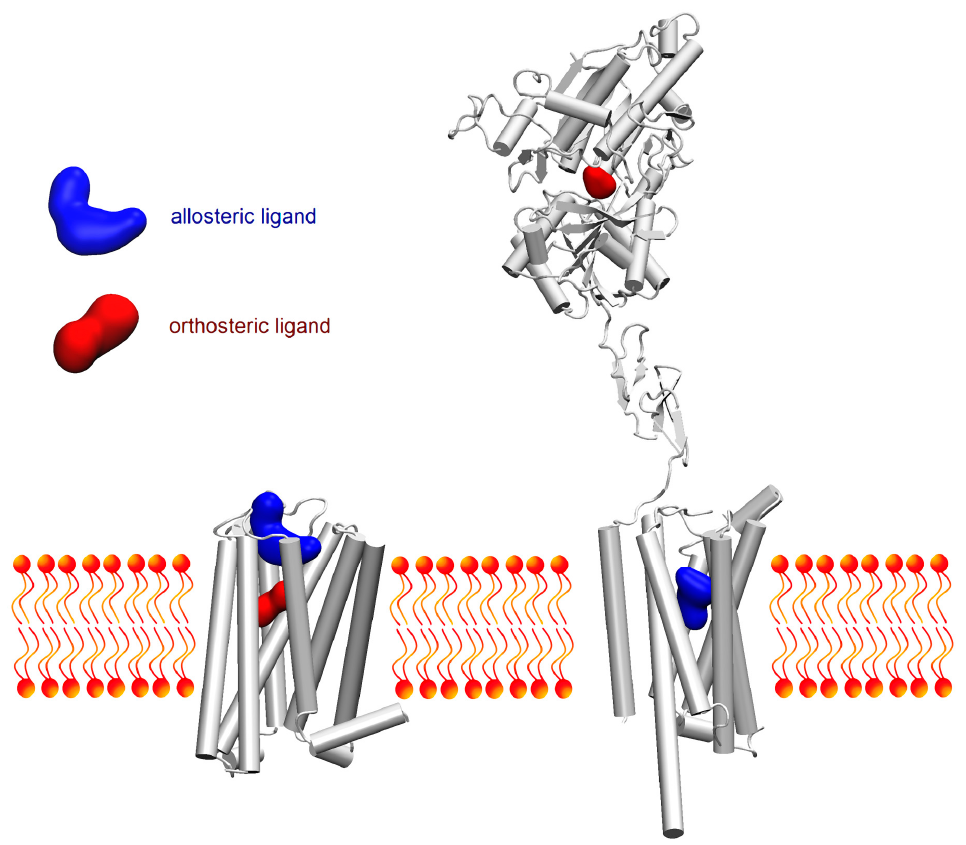
Figure 1. Schematic overview on the most frequent locations of orthosteric and allosteric sites. While in rhodopsin-like receptors orthosteric site tends to be buried inside the transmembrane bundle (left), in most members of other families of GPCRs the orthosteric site is located in large extracellular domains (right). Allosteric sites can be located in various regions of a receptor, but usually small-molecule modulators bind to extracellular vestibule of rhodopsin-like GPCRs (left). In contrast, the most frequently explored allosteric sites in members of other GPCR families are located inside the transmembrane bundle (right), analogically to rhodopsin-like GPCR’s orthosteric sites. M 2 muscarinic receptor (PDB ID: 4MQT) on the left, mGluR3 and mGluR5 glutamate receptor monomer fragments on the right (extracellular and intracellular, PDB IDs: 2E4W and 5CGC, respectively).